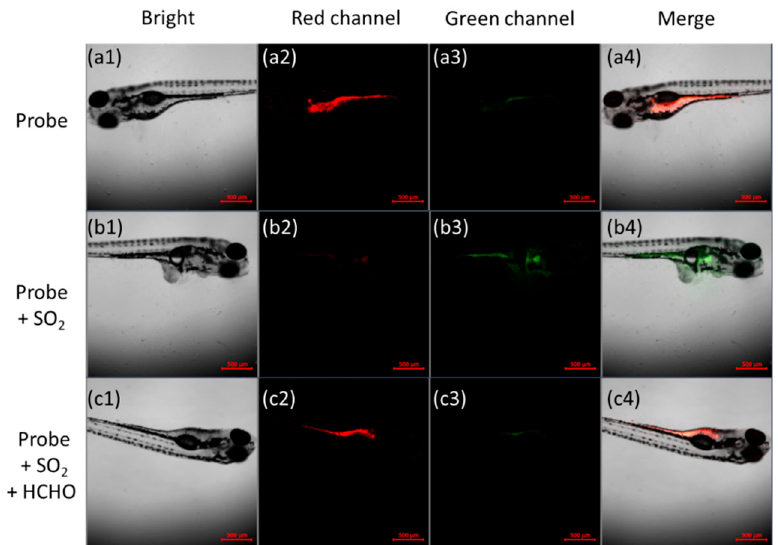
Figure 6. Confocal images of the probe in zebrafish. ( a1 – a4 ) Wild-type zebrafish were incubated with 20 μ M B2P for 0.5 h; ( b1 – b4 ) zebrafish were incubated with 20 μ M B2P for 0.5 h, then incubated with 100 μ M sodium bisulfite for 0.5 h; ( c1 – c4 ) probe-loaded zebrafish were incubated with 100 μ M sodium bisulfite for 0.5 h, and then cultured with 0.5 mM of HCHO for another 1 h. From left to right: bright field; red channel: λ em = 580–650 nm; green channel: λ em = 480–520 nm; merge; scale bar, 500 μ m.